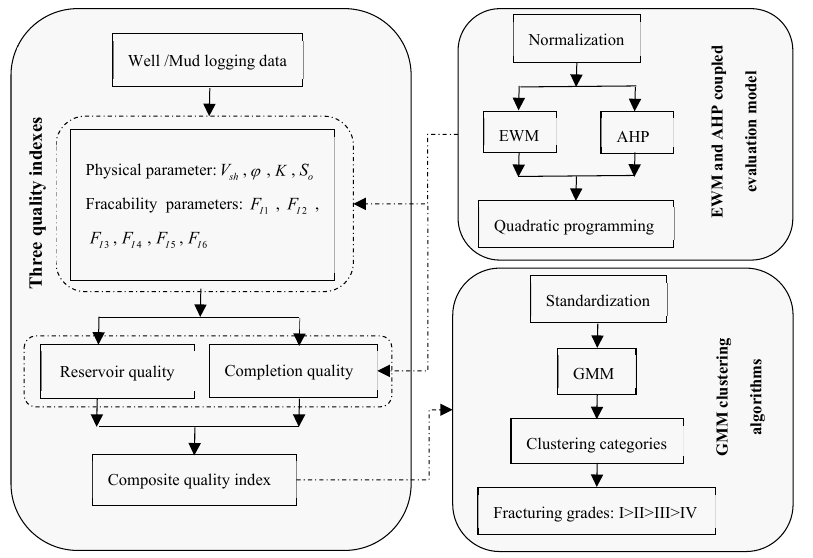
Figure 1. Flowchart of identification of the fracturing grades based on the EWM–AHP coupled evaluation model and GMM clustering algorithms.